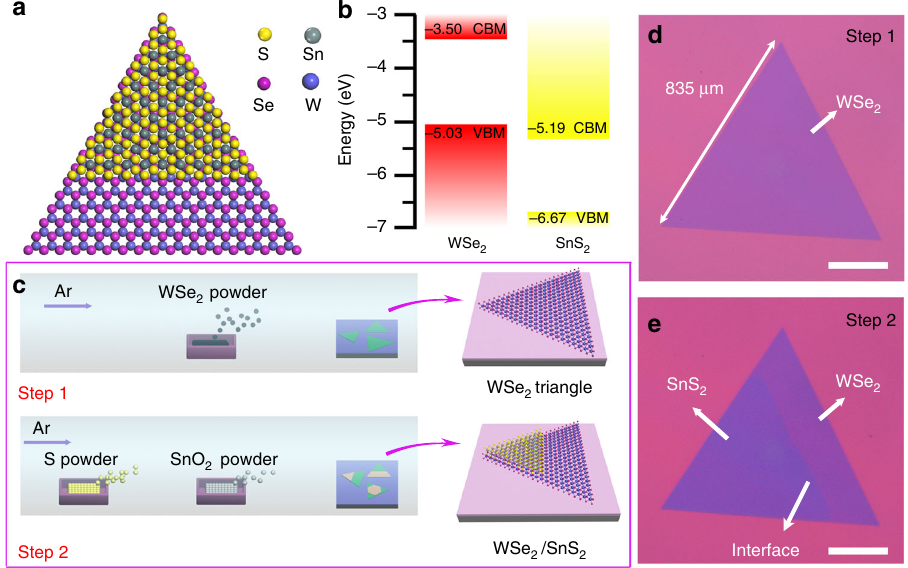
Fig. 1 Synthesis of large-scale type-III WSe 2 /SnS 2 heterostructure. a Schematic of vertically stacked WSe 2 /SnS 2 vdW heterostructure. b Band alignment of type-III WSe 2 /SnS 2 junction. c Schematic illustrating the two-step vapor expitaxy growth of WSe 2 /SnS 2 heterostructure. d Typical optical image of as- grown large-scale monolayer WSe 2 triangular fl ake achieved after step 1. e Optical image of as-grown vertically stacked WSe 2 /SnS 2 heterostructure after step 2 by using the same fl ake in Fig. 1d. All the scale bars: 200 μ